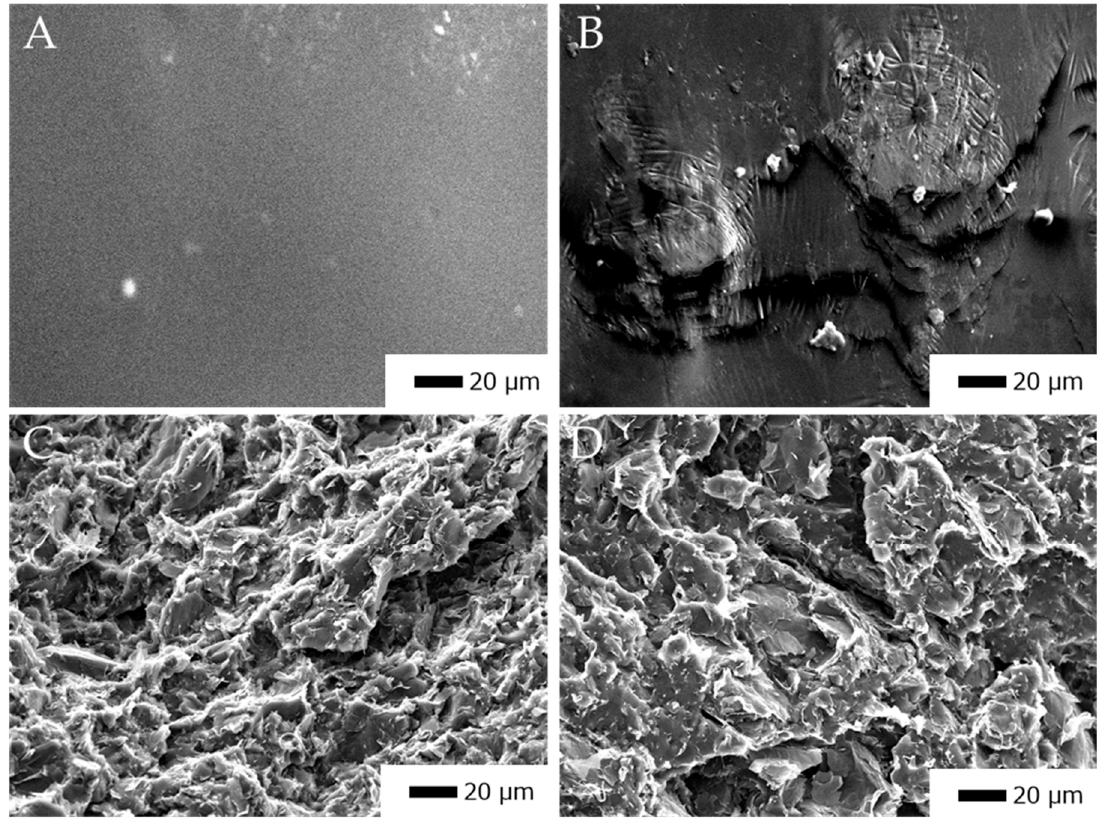
Figure 3. Representative SEM images of ( A ) PLA ( B ) 5% C750/PLA ( α = 222), ( C ) 5% M15/PLA ( α = 1667), and ( D ) 5% M25/PLA ( α = 2778) composites.